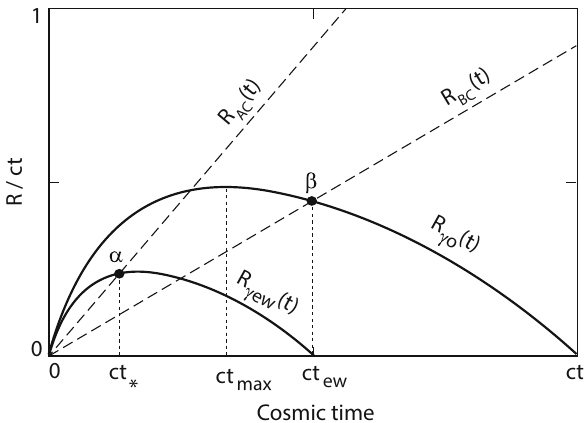
Fig. 2 PhotontrajectoriesasseenbyanobserverinpatchC(seeFig.1) forthe R h = ct universe.Thecurve R γ ew ( t ) representsthenullgeodesic arrivingatCattheelectroweakphasetransitiontime t ew fromanysource emitting light at proper distance R src ( t ) = R γ ew ( t ) at time t < t ew . The other solid curve R γ o ( t ) is the null geodesic for light arriving at C at time t > t ew . The dashed lines R AC ( t ) and R BC ( t ) show the proper distance from A to C and from B to C, respectively. The other labels and symbols are defined in the